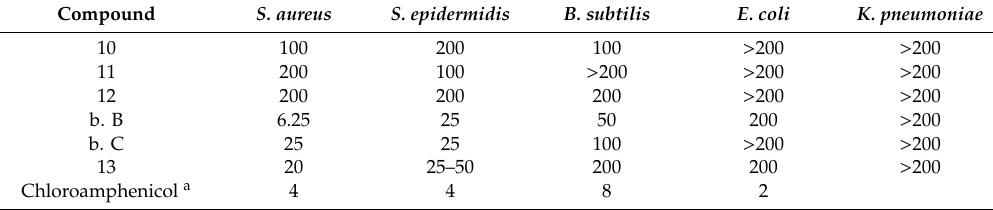
a Chloroamphenicol was used as positive